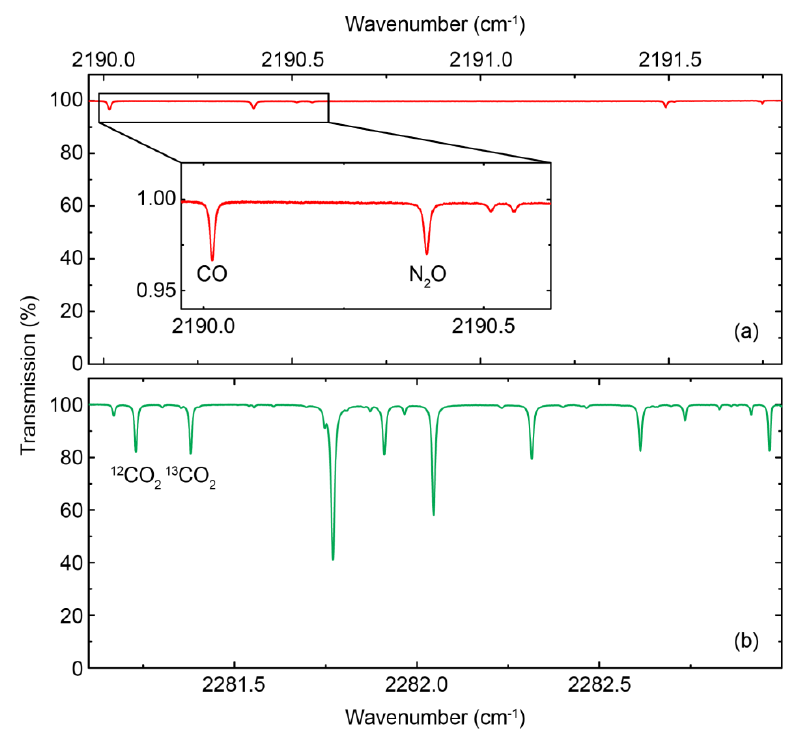
Figure 9. Absorption spectra of dry air recorded at 50 hPa pressure using the front ( a ) and rear ( b ) section of the DFB-QCL. The absorption lines used for the concentration measurements are labeled. The inset in ( a ) shows a close-up of the range with the absorption lines of CO and N 2 O.